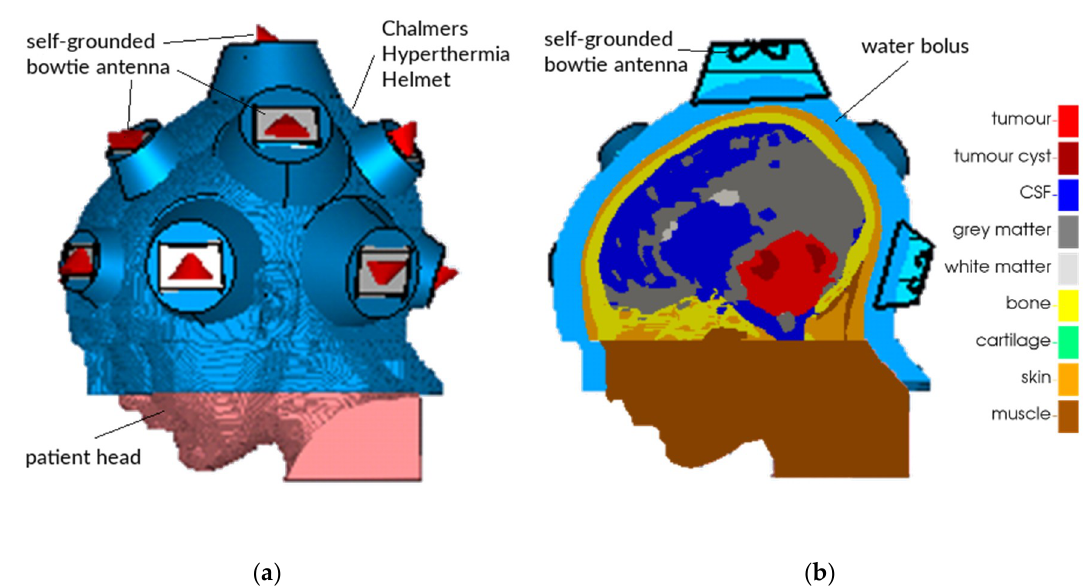
Figure 1. Model of the Chalmers Hyperthermia Helmet. Up to 16 self-grounded bowtie antennas with a frequency range of 300–900 MHz are mounted around the skull. Phase and amplitude can be optimised individually for each antenna, creating a power focus to be steered to the tumour. ( a ) Outside view; ( b ) cross-section of a patient model, showing a large medulloblastoma in red and the water bolus in light blue.